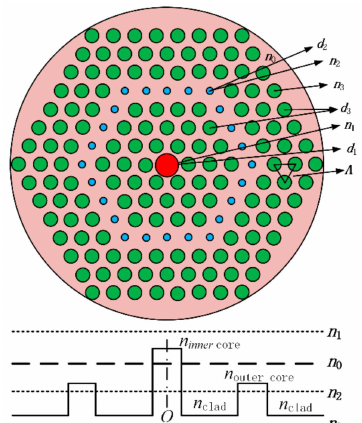
Figure 1. Cross-section and equivalent Re[ n e ff ] profile of all-solid dual-concentric-core microstructure fiber